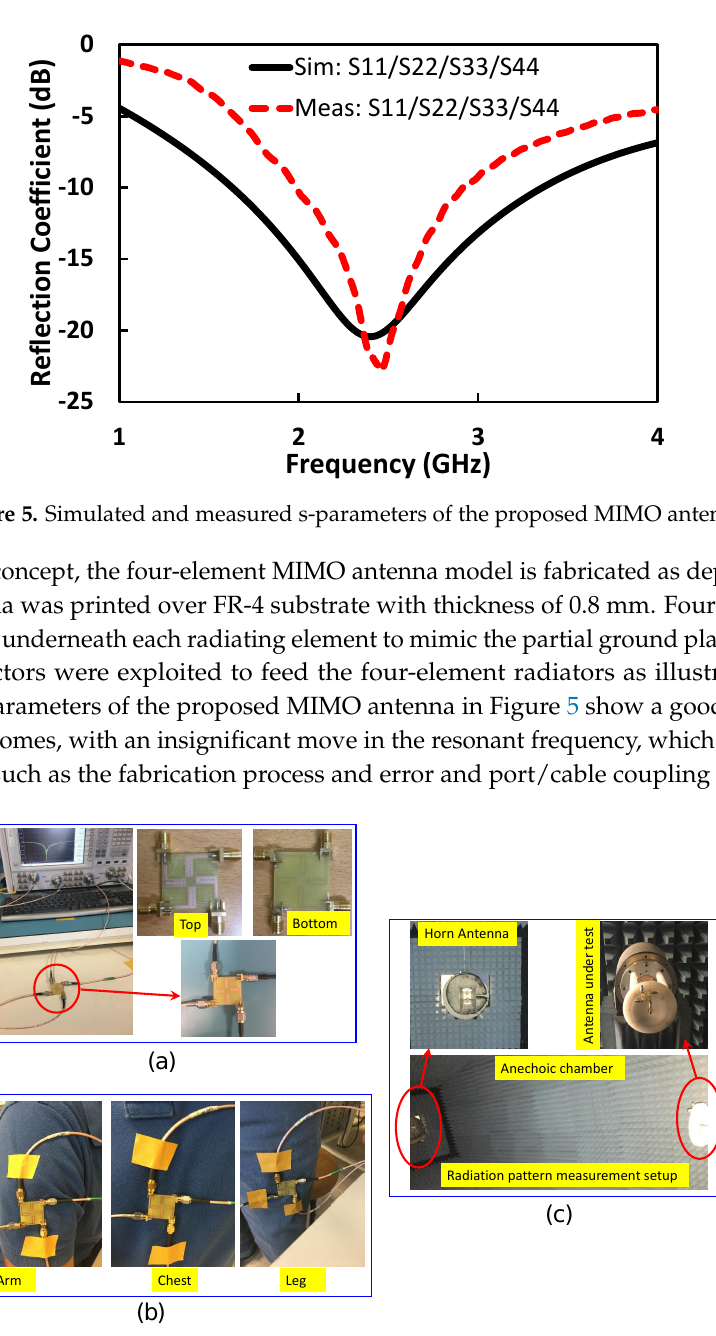
Figure 6. The prototype of the proposed P-shaped MIMO antenna, ( a ) reflection coefficient measurement in free space, ( b ) on-body reflection coefficient measurement, and ( c ) radiation pattern measurement